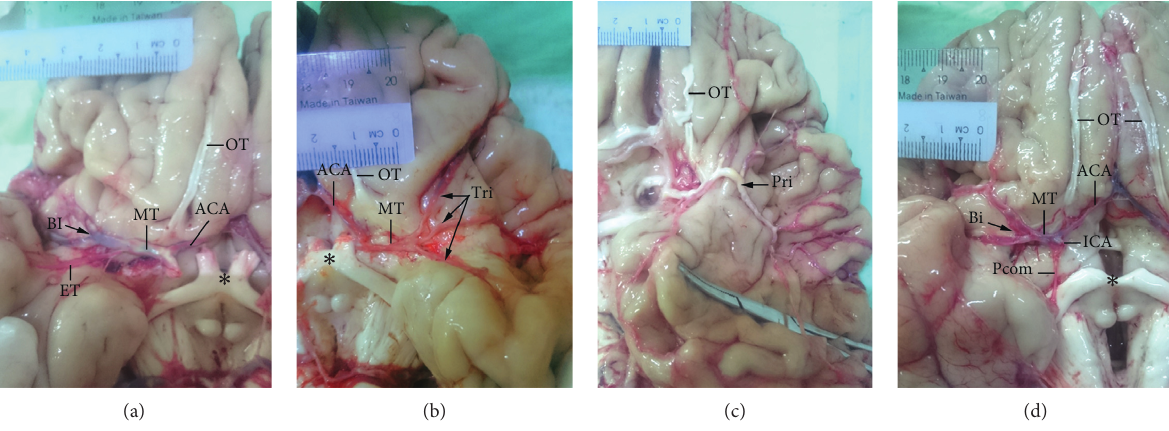
Figure 2: Termination patterns of the MCA. (a) The MTof the MCA terminating as a bifurcation (Bi). (b) The MTof the MCA terminating as a trifurcation (Tri). (c) Primary trunk (Pri) with severe atherosclerosis. (d) Early bifurcation resulting in a short MTjust 6.5mm in length. The ICA, anterior cerebral artery (ACA), posterior communicating artery (Pcom), early temporal branch (ET), olfactory tract (OT) (distorted in panel (c)), and optic chiasma ( ∗ ) are